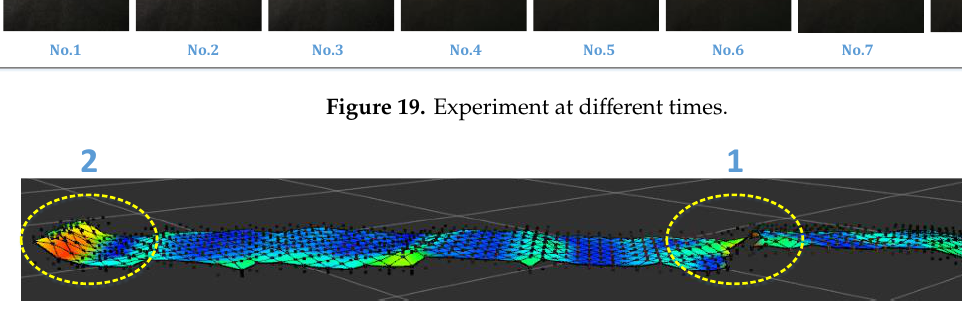
Figure 20. Terrain mapping result.